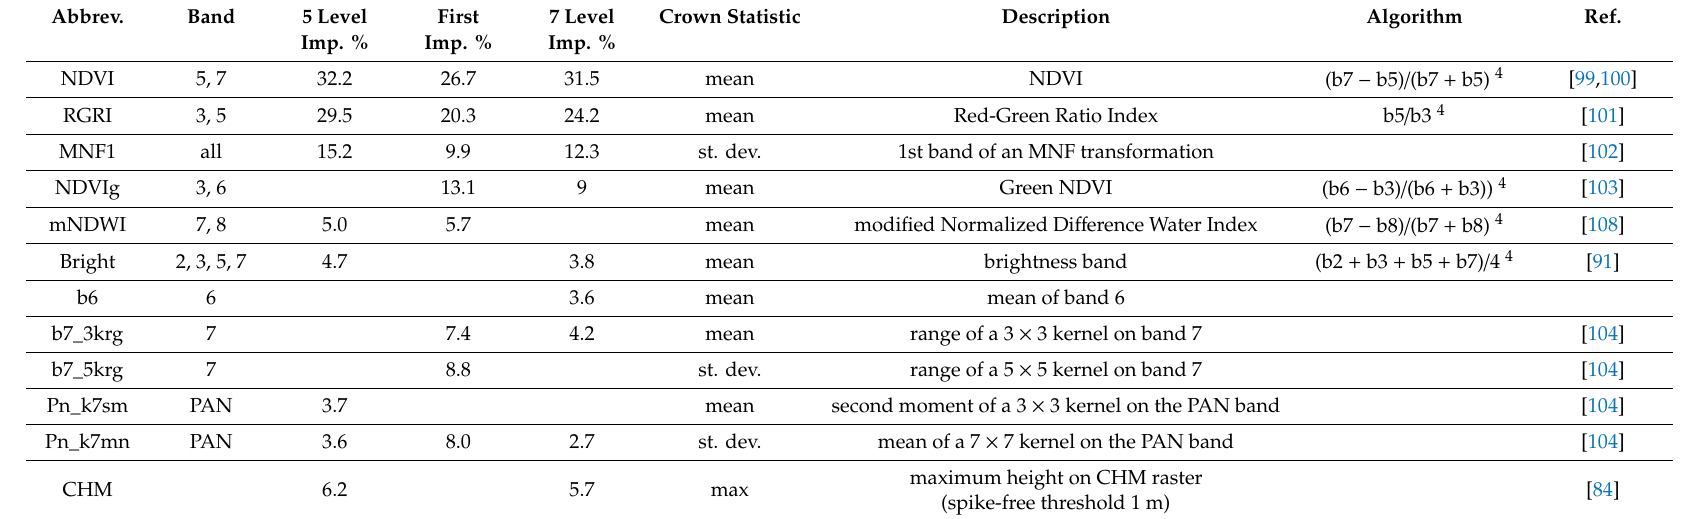
Table A3. Selected attributes and attribute importance in percent for di ff erent stress symptom references (basic 5 levels 1 , first symptoms 2 , refined 7 levels 3 ) based on crowns with a diameter larger than 4 m for WV2 attributes. The attribute importance for an RF regression was calculated as the average impurity decrease and converted to